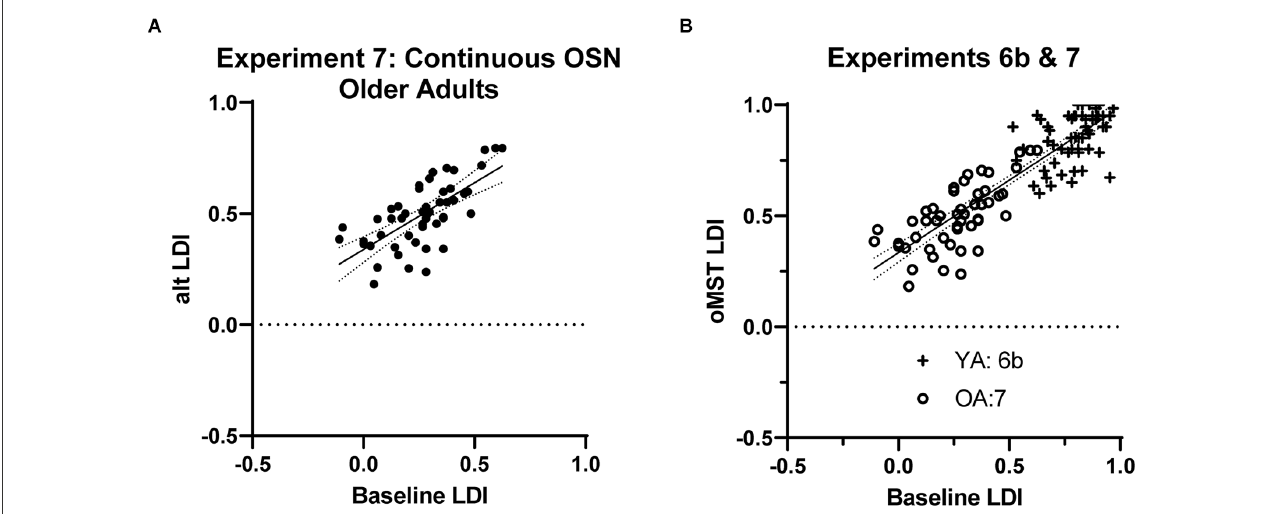
FIGURE4 (A) ResultsfromExperiment7inolderadultsshowedsimilarreliabilityofthereduced,continuous,OSNtaskasshownpreviously. (B) Inadirectcomparison, combining data from this experiment and from the analogous Experiment 6b in younger adults, we find a single model fits the combined data well ( r =